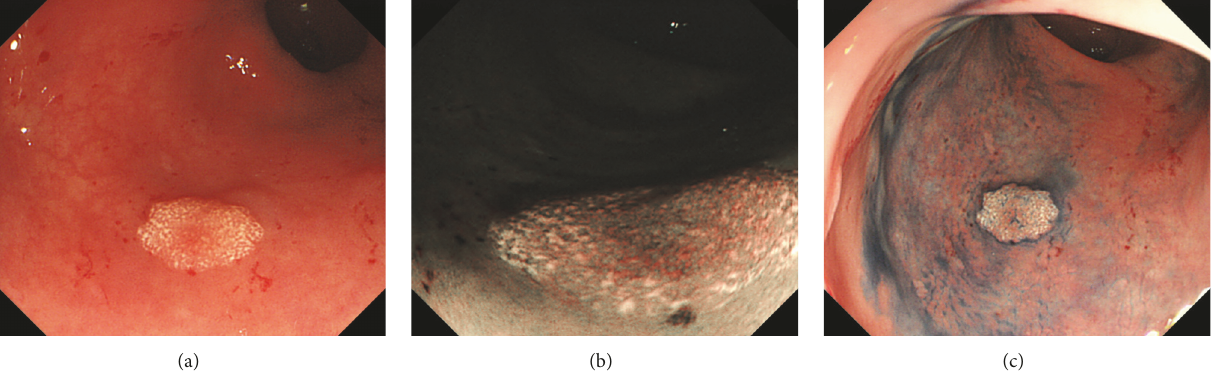
Figure 2: Colonoscopy images of case 2. A whitish plaque of 4 mm in diameter in the rectum is seen (a). Narrow-band imaging (b) and indigo-carmine spraying (c) show whitish lesions more clearly.